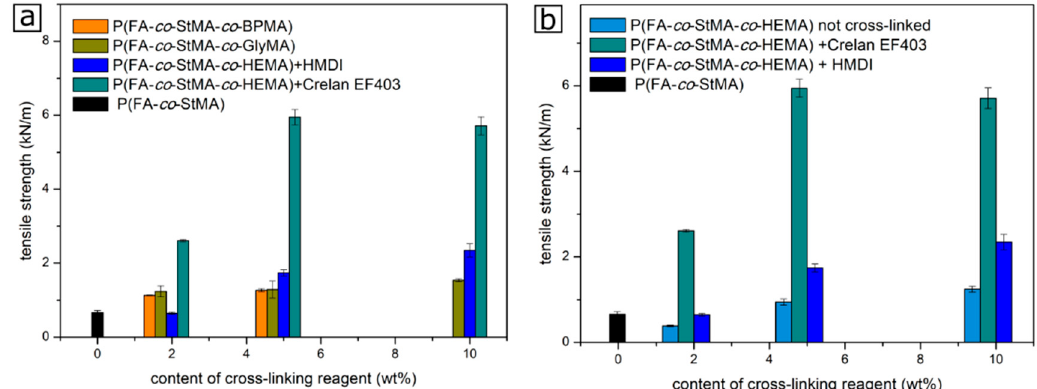
Figure 7. ( a ) Obtained values for the tensile strength of the non-cross-linked and cross-linked cellulose fiber substrates. ( b ) Comparison of tensile strength values for cellulose fibers coated with P(FA- co -STMA- co -HEMA) and after thermally induced cross-linking reaction with the different diisocyanates.